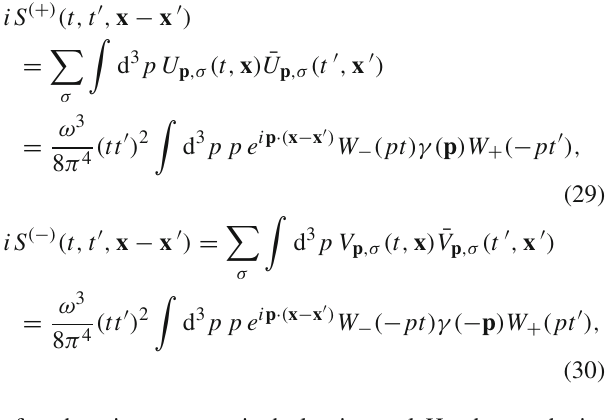
transforms. The form of the matrix functions (29) and